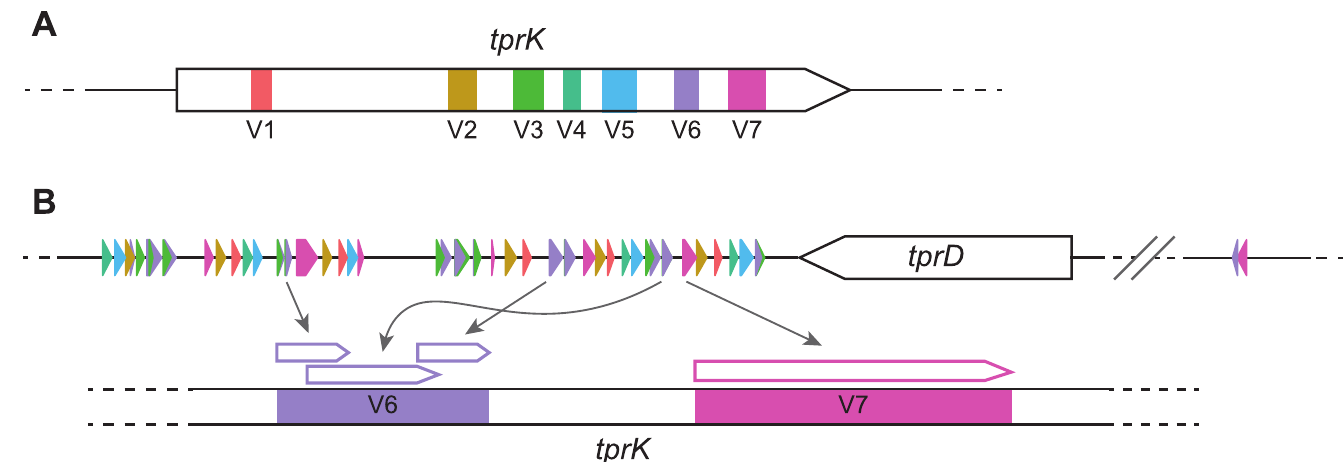
Fig 1. Anatomy of the tprK gene and mechanism of antigenic variation. (A) tprK is composed of seven discrete variable regions (V1 –V7), color-coded here. (B) Flanking the tprD ORF (not to scale) are donor site segments used to generate unique V region sequences, again color-coded by their use in their respective variable regions. 51 of the known 53 donor sites are present in the 3’ flanking region. The segments used can be complete or partial, and vary in number for each V region sequence. They are combined through non-reciprocal segmented gene conversion to create antigenic variation.